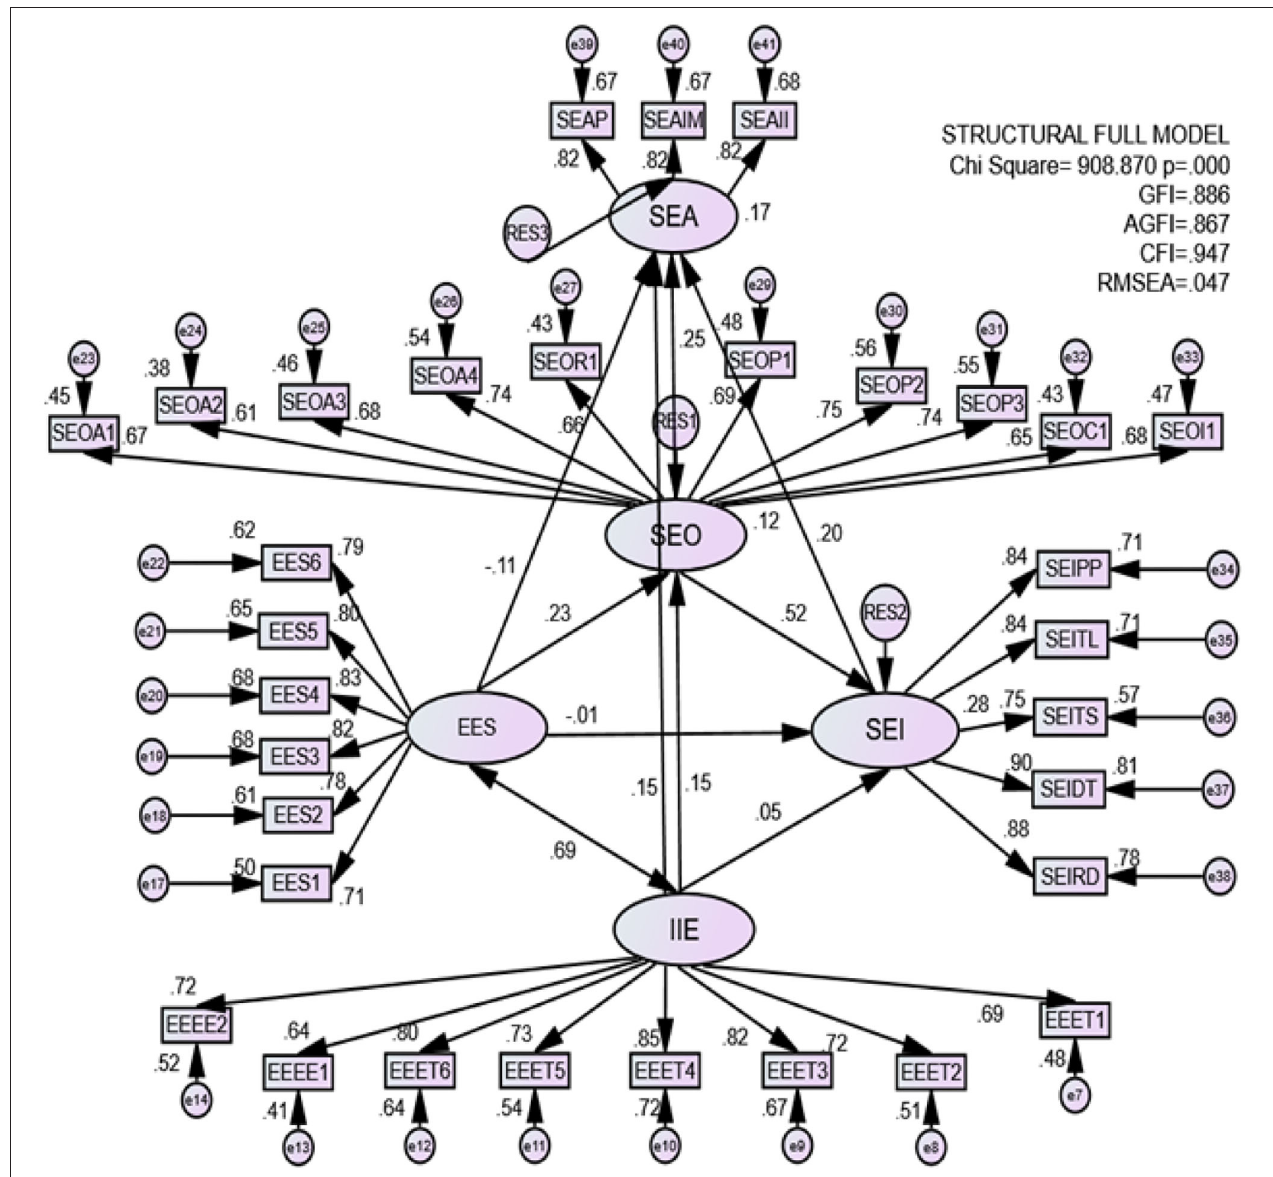
FIGURE 3 | Structural